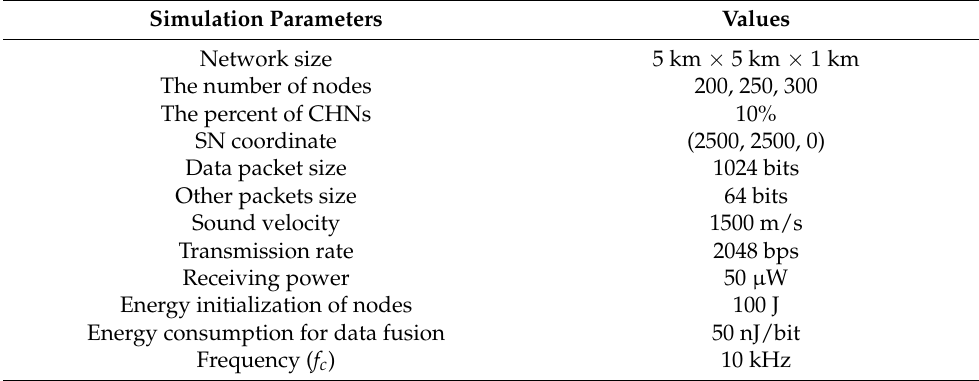
Table 1. The simulation parameters.